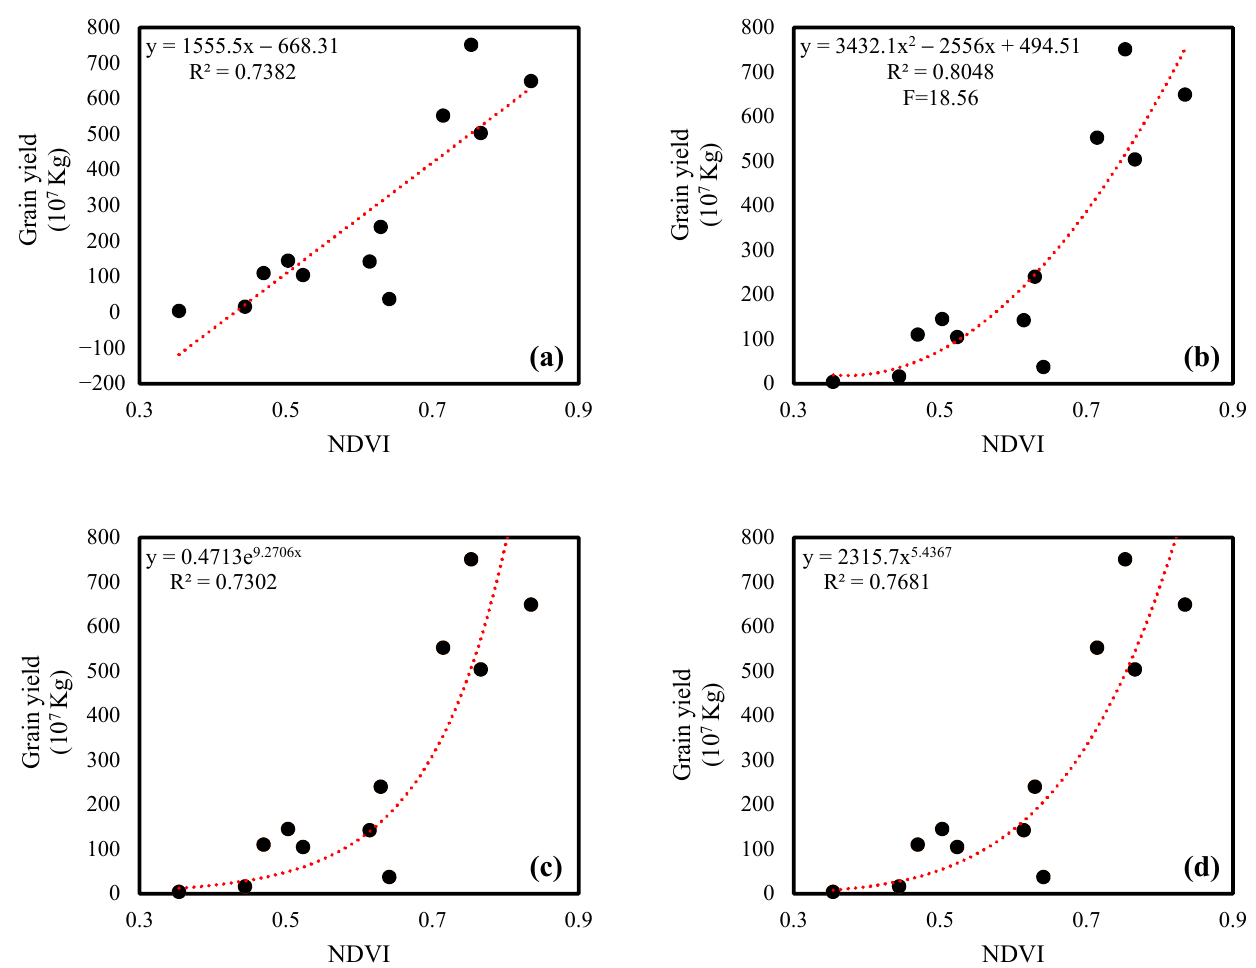
Figure A3. Statistical relationship between NDVI and grain yield. ( a ) Linear algorithm; ( b ) quadratic polynomial algorithm; ( c ) exponential algorithm; ( d ) power function algorithm.